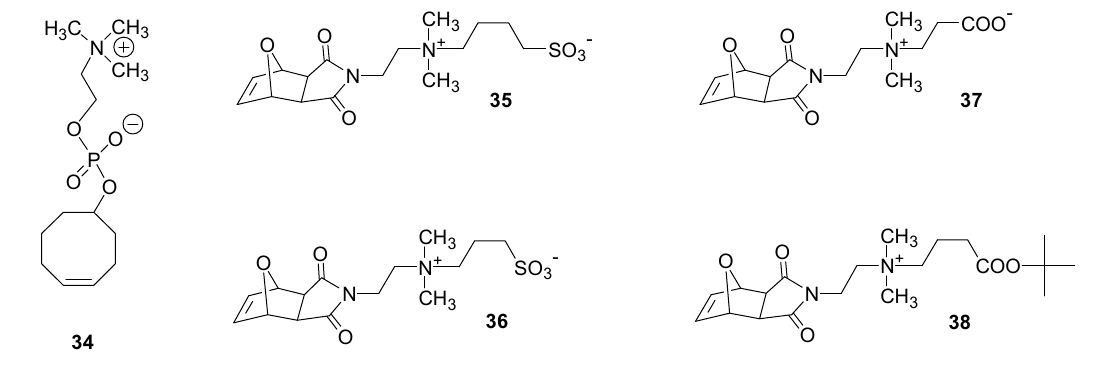
Figure 6. Zwitterionic monomers employed in ring opening metathesis polymerization (ROMP), including phosphobetaine 34 [352], sulfobetaines 35 and 36 [349,350,354,357], and carboxybetaines 37 and 38